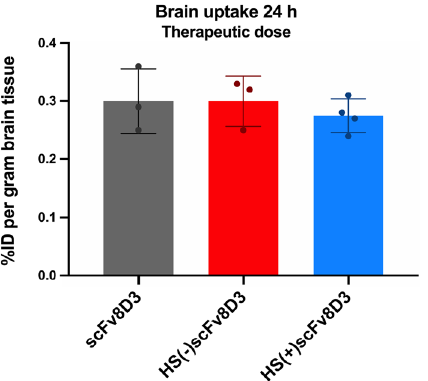
Figure 7. Brain uptake of therapeutic doses of [ 125 I]scFvs constructs. Brain uptake values for the three [ 125 I] labelled scFv constructs administered intravenously at a therapeutic dose (30 nmol/kg). The activity was measured 24 h post-injection. [ 125 I]scFv8D3 (n = 3), [ 125 I]HS(−)scFv8D3 (n = 3) and [ 125 I]HS(+)scFv8D3 (n = 4). Results are presented as mean ± SD.